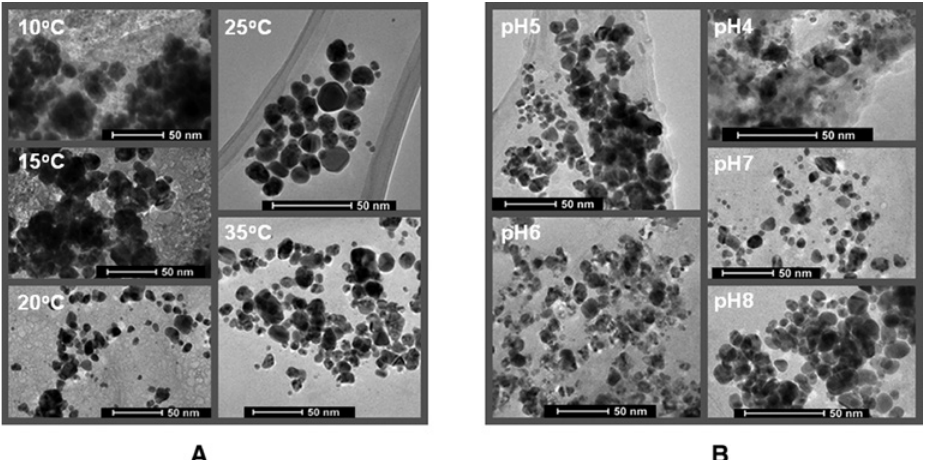
Figure 4: TEM analyses of AgNPs synthesized at different pH and temperature by using N. valliformis OT1 strain. Synthesis at different temperatures (A), synthesis at different pH (B).